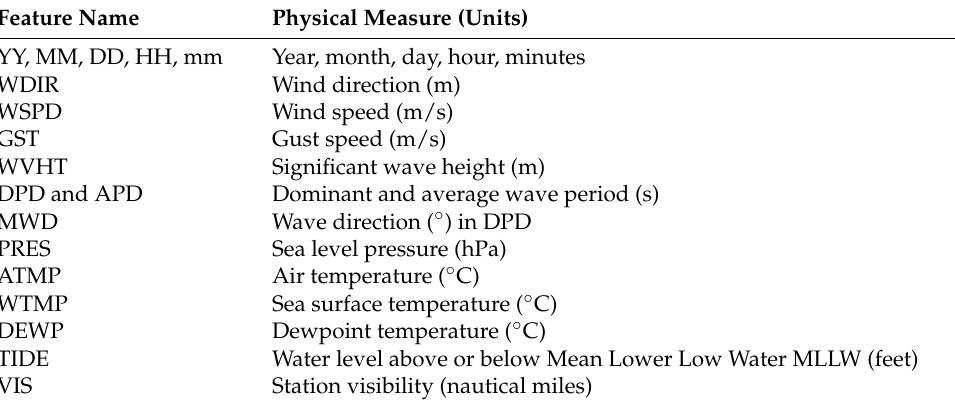
Table 2. Meteorological features measured.